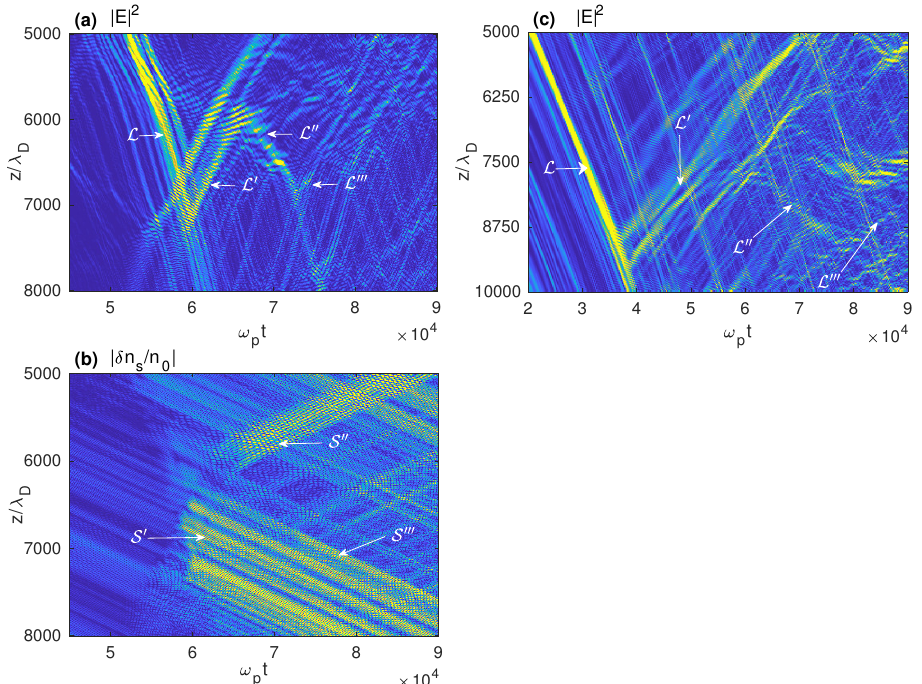
Figure 10. Cascades of wave decay. Space and time variations of | E | 2 ( a ) and of the corresponding short-scale density fluctuations | δ n s | / n 0 ( b ), in the area [ 5000,8000 ] λ D of the simulation box. ( c ) Space and time variations of | E | 2 in the area [ 5000,10,000 ] λ D of the simulation box. The main parameters are the following: ( a , b ) n b / n 0 = 5 × 10 − 5 , v b / v T = 14, ∆ n = 0.02 > ∆ n s ; ( c ) n b / n 0 = 5 × 10 − 5 , v b / v T = 16, ∆ n = 0.01 > ∆ n s . Langmuir and ion acoustic wave packets participating to decay processes are indicated by arrows. All variables are